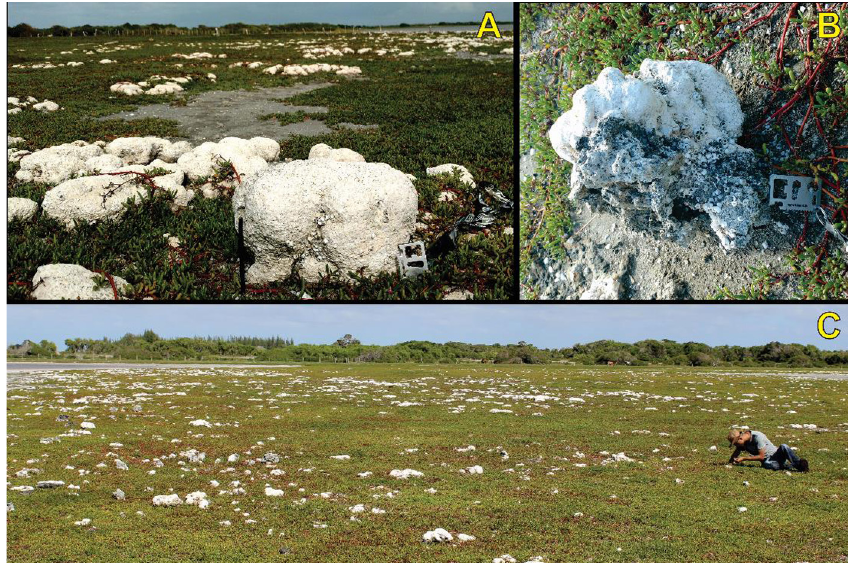
Figure 5 - Exposure of small domal stromatolites. A) Outcropping biostructure in life position; B) Remobilized stromatolite;